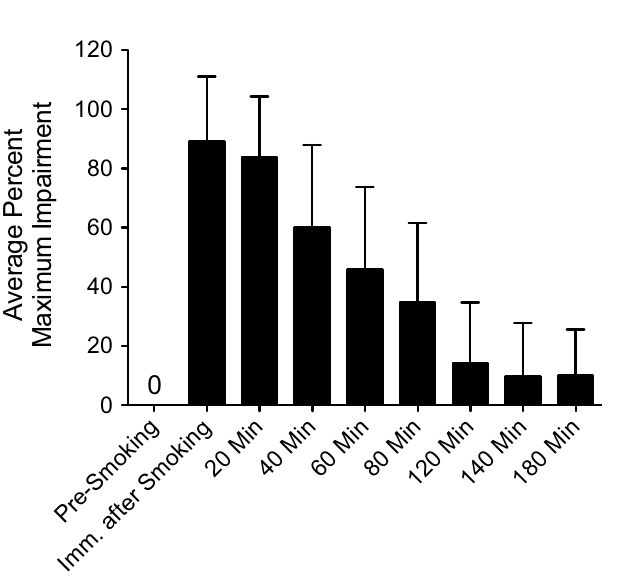
Figure 1. Baseline ∆ 9 -THC blood concentrations in a group of 30 subjects. Pre-smoking (baseline) ∆ 9 -THC blood concentrations were evaluated by LC-HRMS in a group of 30 subjects prior to smoking a 500-mg cannabis cigarette. The horizontal red bar indicates the median concentration (6.4 ng/mL), and the horizontal black bar at 5 ng/mL indicates a common legal per se ∆ 9 -THC blood concentration limit. One subject not shown (∆ 9 -THC not detected).